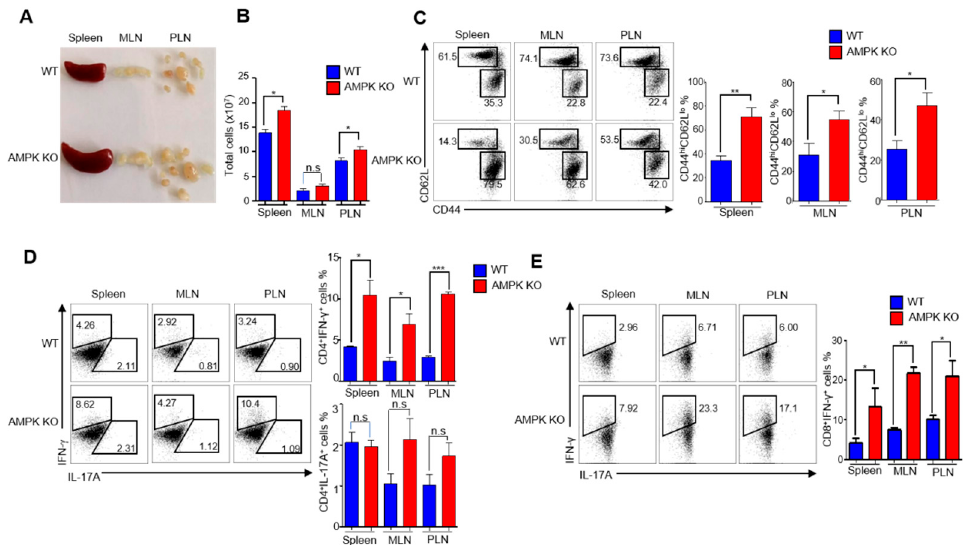
Figure 4. Regulatory T cell (Treg)-specific AMP-activated protein kinase (AMPK) deletion develops spontaneous systemic lymphoproliferative disease with age. ( A ) Representative image of spleen, mesenteric lymph nodes (MLN), and peripheral lymph nodes (PLN) from 24–30-week-old Foxp3 ypf-cre (WT) and AMPK α 1 fl/fl Foxp3 YFP-Cre (AMPK-KO) mice. ( B ) Total cell number in spleen, MLN, and PLN of WT and AMPK-KO mice. ( C ) Expression of percentage of CD62L and CD44 in CD4 + T cells from the spleen, PLN, and MLN from WT and AMPK-KO mice (left) and the bar diagram representatives of CD62L hi CD44 lo percentage (right). Flow cytometric analysis of the percentage of ( D ) IFN- γ - and IL-17A-producing CD4 + T cells and ( E ) IFN- γ -producing CD8 + T cells in lymphocytes isolated from the spleen, MLN, and PLN of WT and AMPK-KO mice. * p < 0.05, ** p < 0.01, *** p < 0.001 and n.s means non-significant ( p > 0.05).